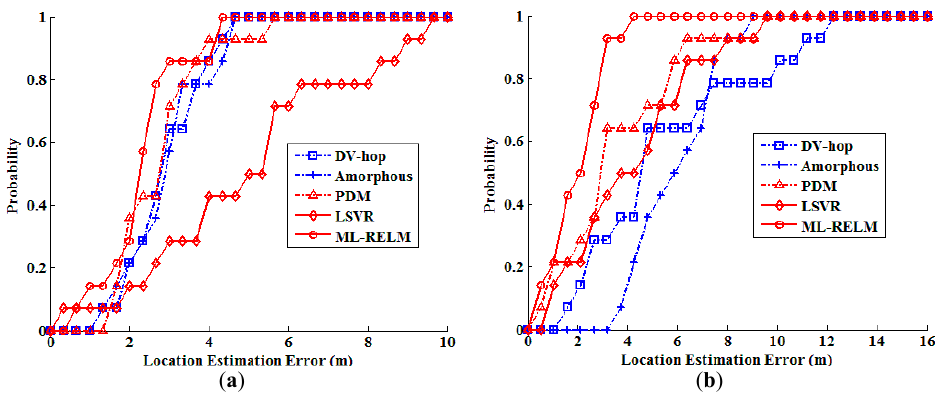
Figure 15. The Cumulative Distribution Function (CDF) of the errors in realistic scenarios ( a ) CDF of outdoor; ( b ) CDF of indoor.